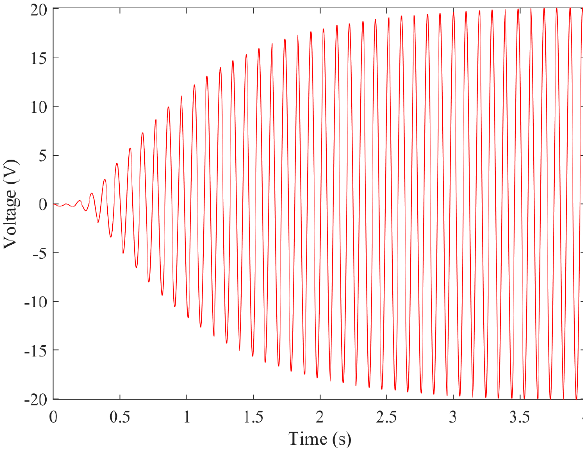
Figure 3. Time history voltage response ( U = 4.0 m/s).